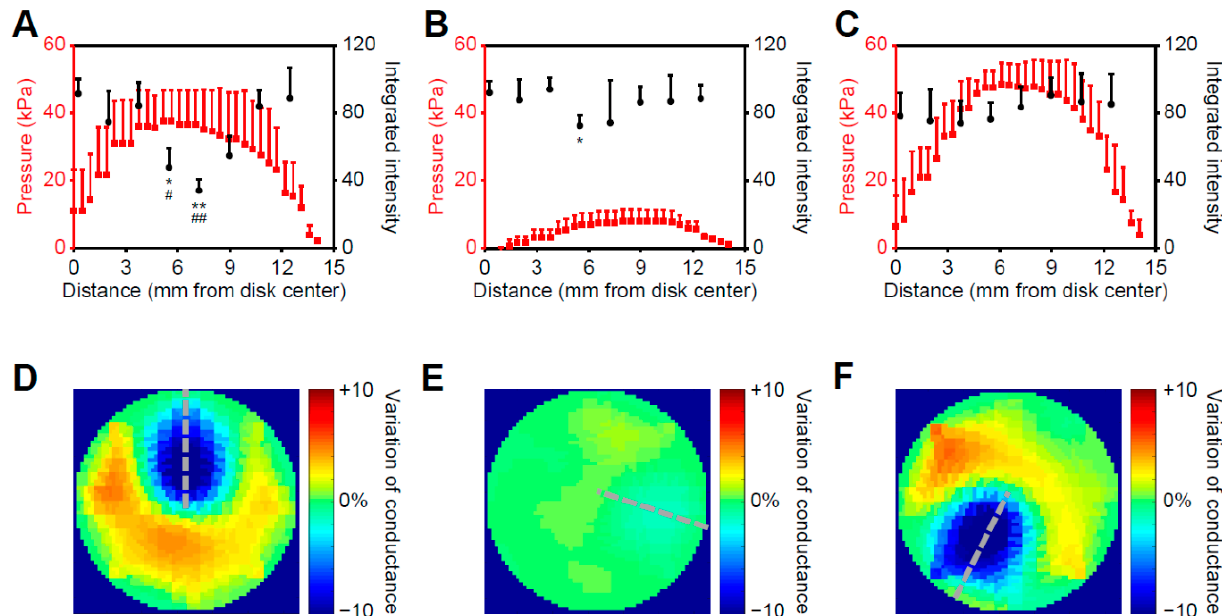
Figure 4. Calcium intensities after cryoablation and recorded pressure profiles along the radius of disks are presented in the same figure to show the correspondence. ( A – C ) represent the conditions of normal pressure with cryoablation, minimum pressure with cryoablation, and normal pressure without cryoablation, respectively. The red dots and the black dots indicate the recorded pressures and the calcium intensities of cardiomyocytes from the same radius of each disk, respectively. ( D – F ) are reconstructed conductance maps showing three pressing locations under normal pressure with cryoablation, minimum pressure with cryoablation, and normal pressure without cryoablation, respectively. The gray-dotted lines indicate the pressure profiles in figure ( A – C ). * p < 0.05, ** p < 0.01 for comparison between the pre-ablation group and the post-ablation group ( n = 3), two-tailed Student’s t -test. # p < 0.05, ## p < 0.01 for comparing to the group nearest to the disk center (0.2 mm) ( n = 3), 1-way ANOVA with Tukey post hoc test.